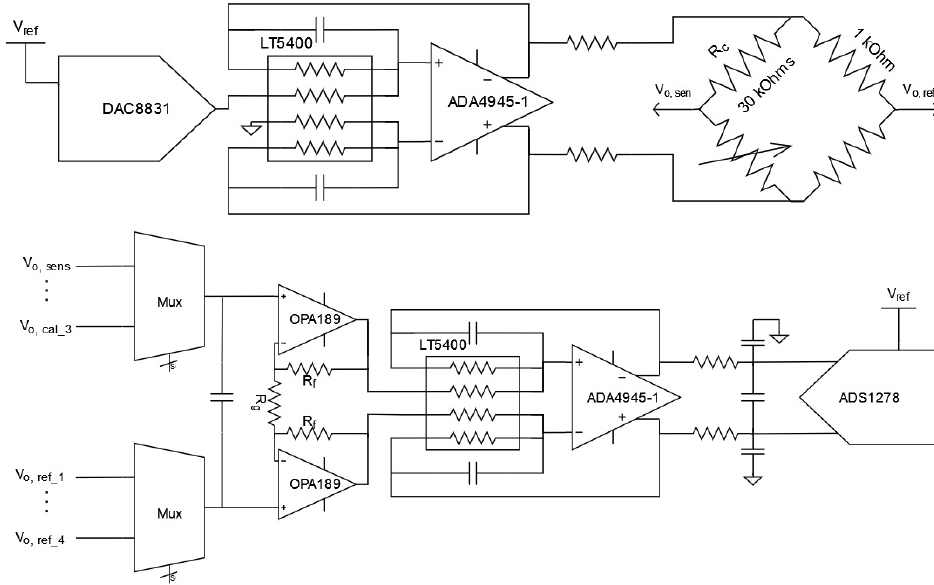
Figure 2. ( Top ): Modulation circuit with Wheatstone bridge. ( Bottom ): Acquisition chain of the output of the Wheatstone